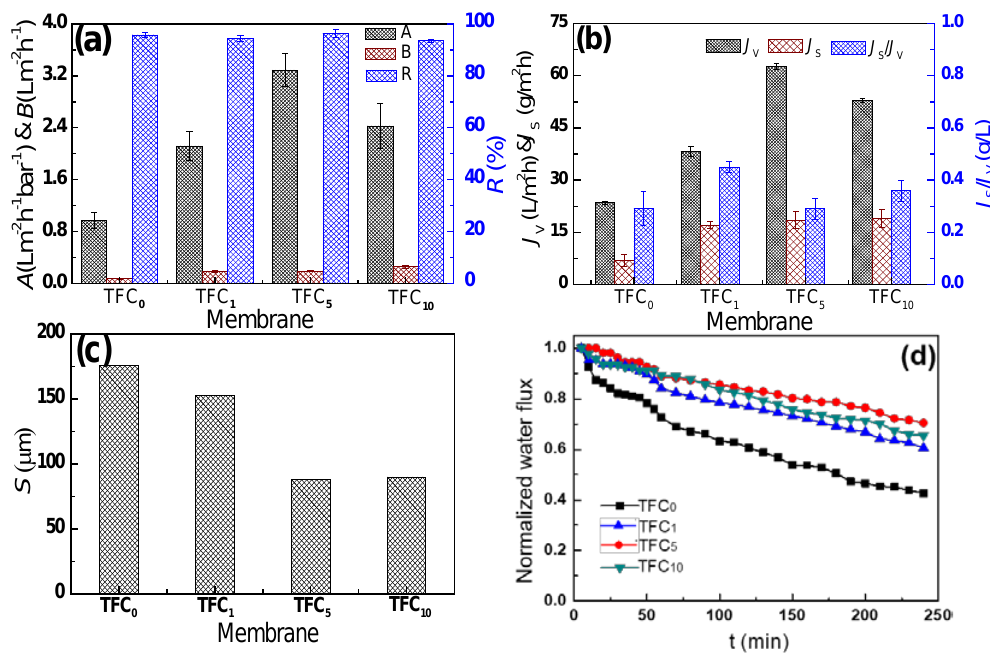
Figure 7. Separation performance of prepared TFC membrane with various SWCNTs interlayer. ( a ) Intrinsic separation properties including water permeability coefficient ( A ), salt permeability coefficient ( B ) and salt rejection ( R ), ( b ) FO performance including water flux ( J v ), reverse salt flux ( J s ) and the ratio of reverse salt flux to water flux ( J s / J v ), ( c ) membrane structural parameter ( S ) and ( d ) time-dependent normalized water flux.